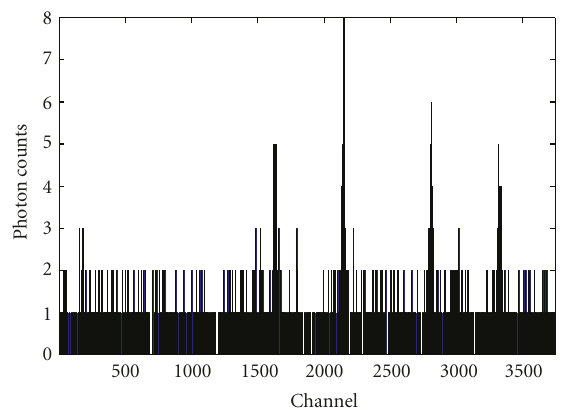
Figure 2: Multiple returns recorded from a distributed target in the field of view of a single pixel. The horizontal axis is equivalent to the round-trip distance, and the vertical axis a measure of the strength of signal